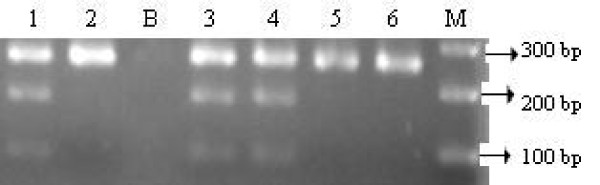
Lane 1, 3 and 4 represents heterozygous +/- genotypes and lane 2, 5 and 6 represents homozygous -/- genotypes of MboI polymorphism of renin gene. M represents 100 bp ladder and B represents the negative control without the template DNA.